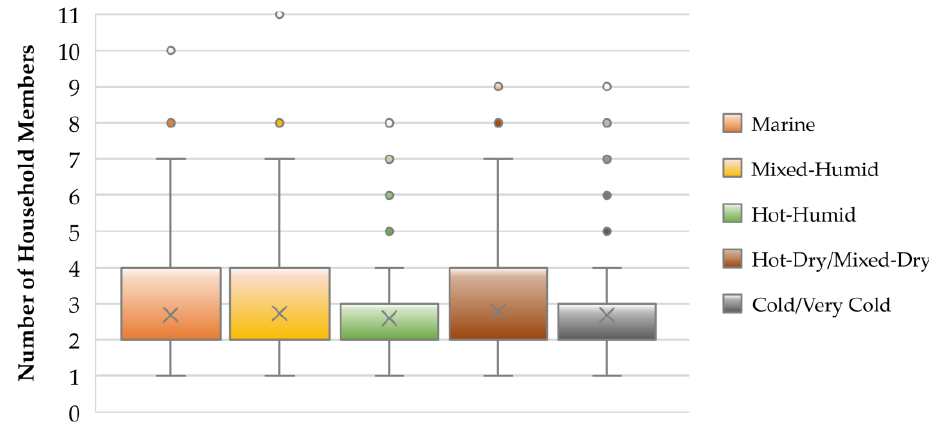
Figure 6. 2014 annual household income brackets per climate zone (total n = 3288). In general, each household contained a minimum of one and a maximum of 11 mem- bers, with a mean of 2.69 people per household and a standard deviation of 1.396. In the case of household members, the median was 2 people per household for all regions. The mean number of people varied from a low of 2.60 in the Hot-Humid region to a high of 2.79 in the Hot-Dry/Mixed-Dry region. Figure 7 shows a box plot representation for the number of household members in each surveyed climate region and indicates a higher variability in the Marine, Mixed-Humid, and Hot-Dry/Mixed Dry regions, in which most homes house two to four people than Hot-Humid and Cold/Very Cold regions, in which most homes have two to three people only.